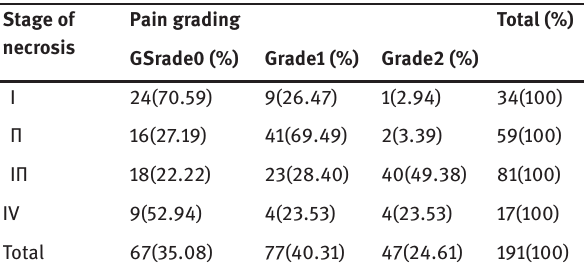
Table 2: Quantitative distribution of hip pain grades in various necrosis